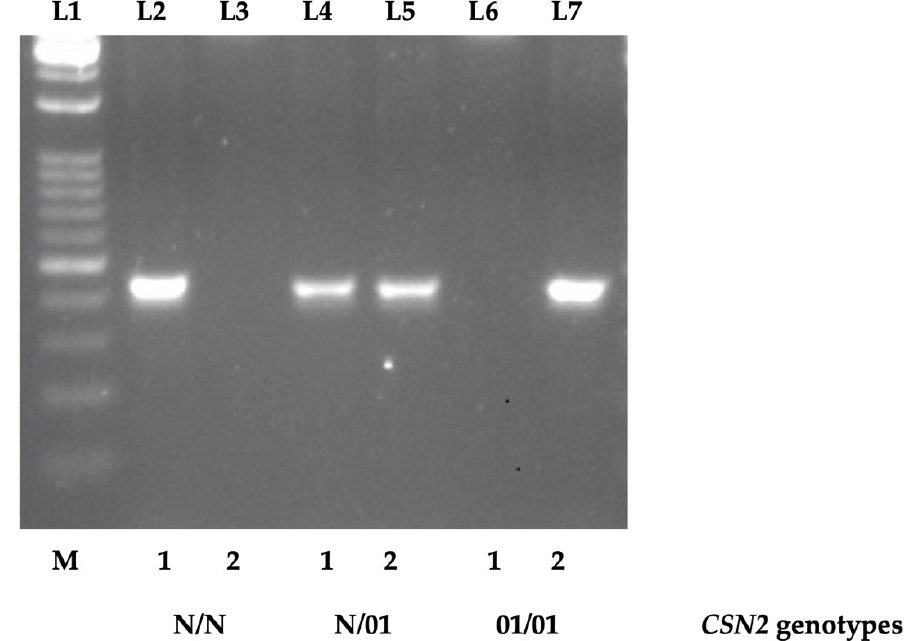
Figure 1. Electrophoretic patterns of fragments obtained with the new AS-PCR protocol of the goat carriers of the AJ011018:g.8915C>T mutation at the CSN2 locus . M = marker (1kb Opti-DNA Ladder, 0.1–10 kb, Applied Biological Materials, ABM). 1, “g.8915C” allele-specific primer (primer name, CSN2N); 2, “g.8915T” allele-specific primer (primer name, CSN201). N: non- CSN2 01 alleles (A, A1, B, C, C1, D, E, F, and 0); 01: CSN2 01 allele. N/N, N/01, and 01/01: reference samples of individuals with known genotypes. L1: Marker; L2 and L3: N/N goat; L4 and L5: N/01 goat; L6 and L7: 01/01 goat. Typing of the reference samples (2 CSN2 N/01 and 2 CSN2 01/01) was accomplished eight times with identical results. Table 1. Genotype numbers (observed and expected), allele frequencies, and population indices observed at the CSN1S1 locus in Capestrina, Bianca Monticellana, and Ciociara Grigia populations.